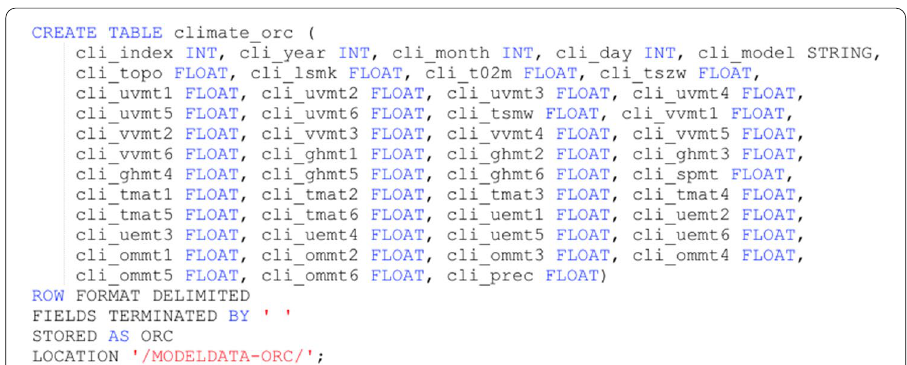
Fig. 15 The DDL code to create the Hive Table in ORC